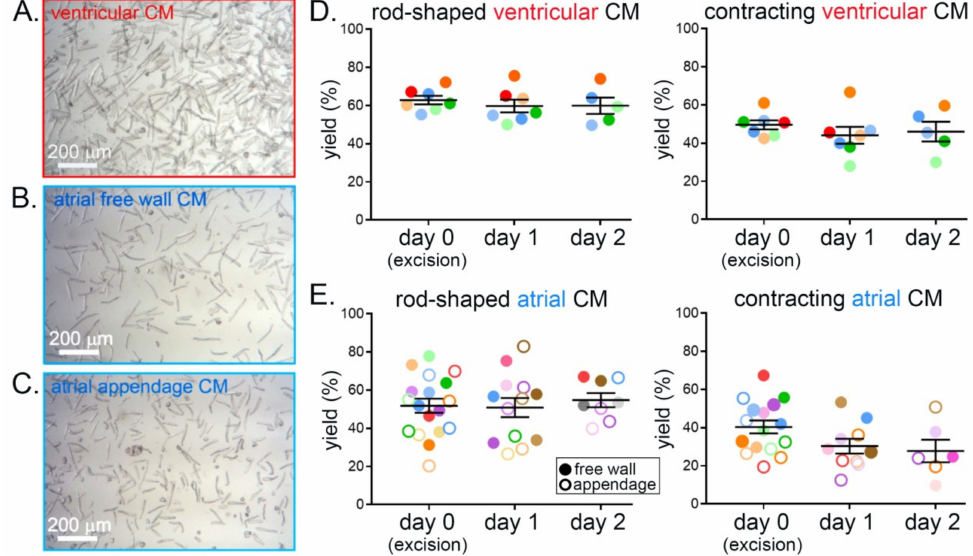
Figure 2. Yield of calcium-tolerant rabbit ventricular and atrial CM does not show statistically signifi- cant differences on three consecutive days of cell isolation from the same heart. ( A ) Representative brightfield microscopy image of ventricular CM after isolation. ( B ) Representative brightfield mi- croscopy image of atrial free wall CM after isolation. ( C ) Representative brightfield microscopy image of atrial appendage CM after isolation. ( D ) Yield (percentage of all cells in the field of view) of rod-shaped and of contracting (upon stimulation; stimulation rate 0.5 Hz) ventricular CM on three con- secutive days of isolation from tissue slices of the same heart; n = 5–7 hearts, 13,000–30,000 CM/day of isolation. ( E ) Yield of rod-shaped and of contracting atrial CM (stimulation at 1 Hz; free wall— filled circles; appendage—open circles); n = 3–10 hearts, 800–5700 CM/day of isolation. Each color represents data from one